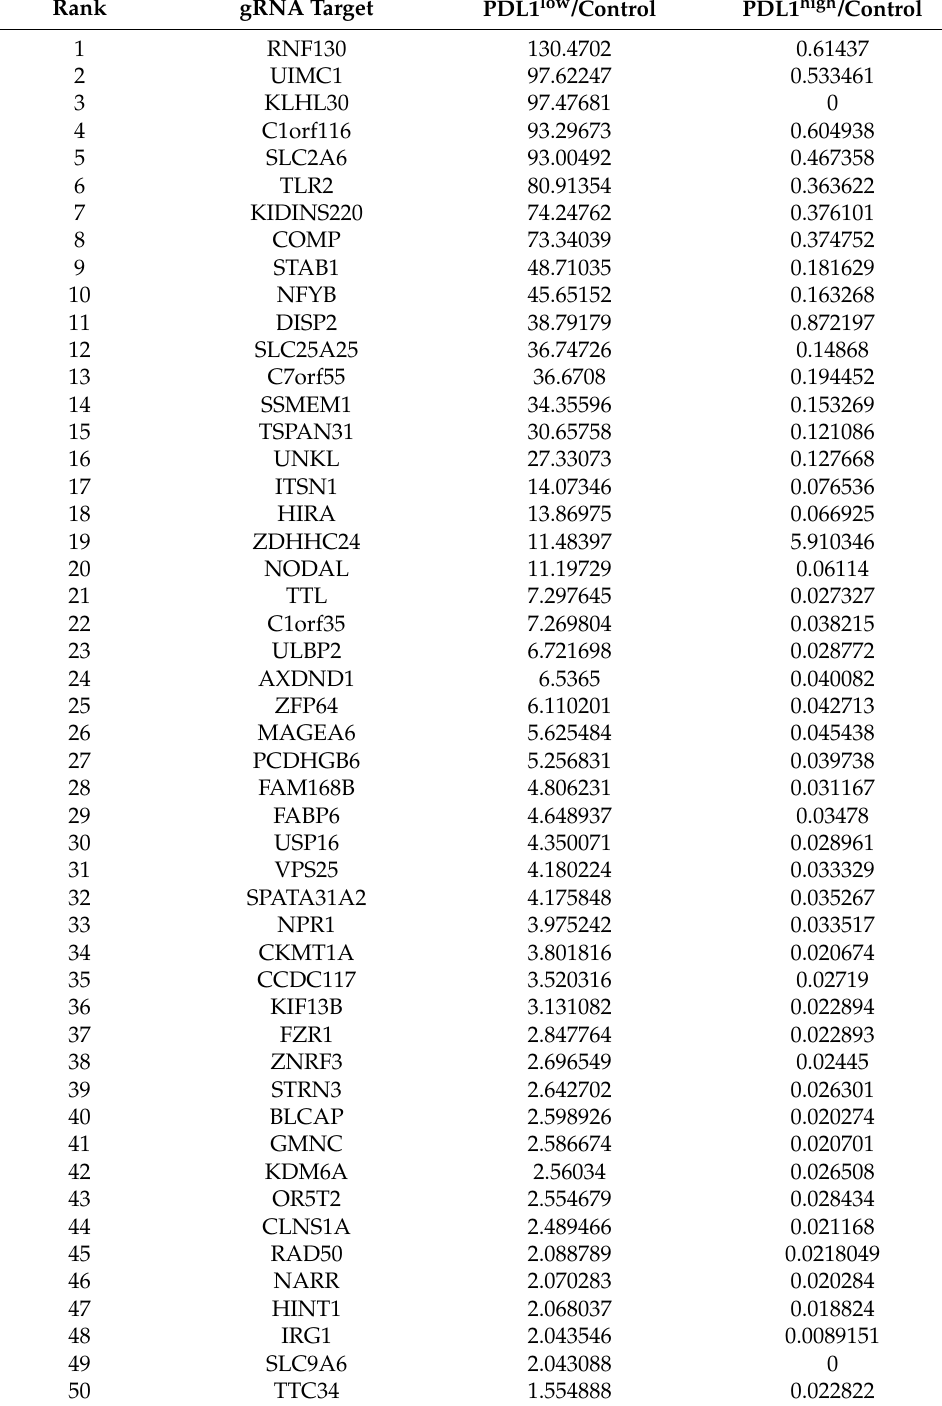
Table 1. gRNAs ranked by enrichment in PDL1 low over